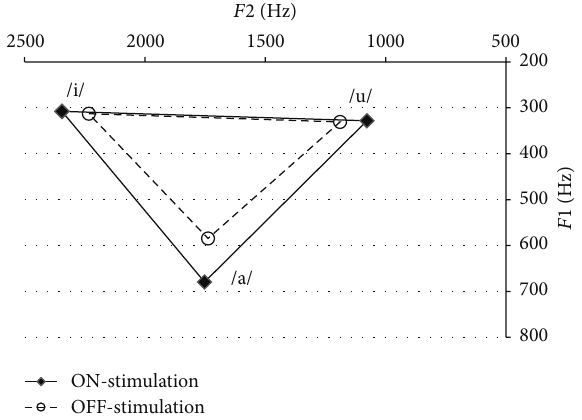
Figure 1: Acoustic space of average 𝐹1 and 𝐹2 values of the vowels /i/, /u/, and /a/ during OFF-stimulation and